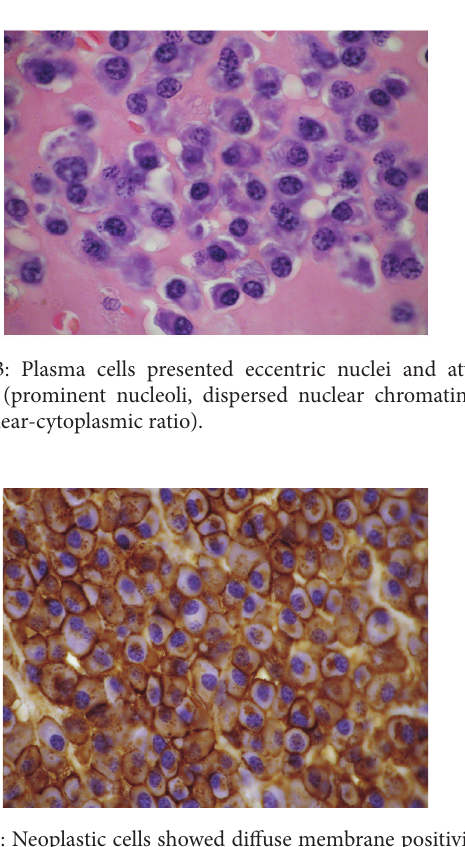
patency. No lymph node enlargement was detected at neck palpation.